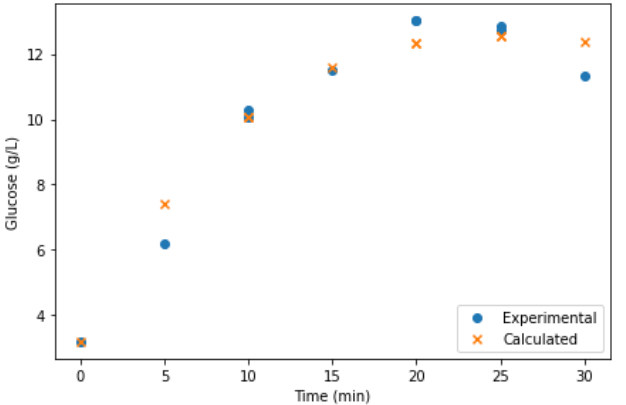
Figure 5. Glucose concentration vs. time plots using experimental data (points) and application of the Saeman model (x) Equation (9).